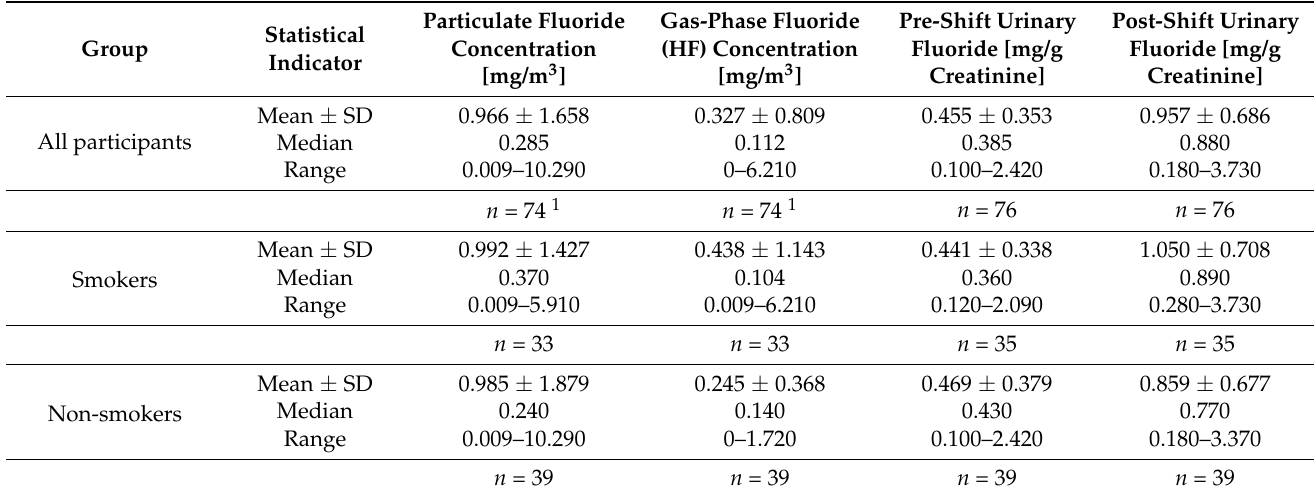
Table 2. Mean fluoride concentration, standard deviation, and maximum and minimum values in occupational air and in urine